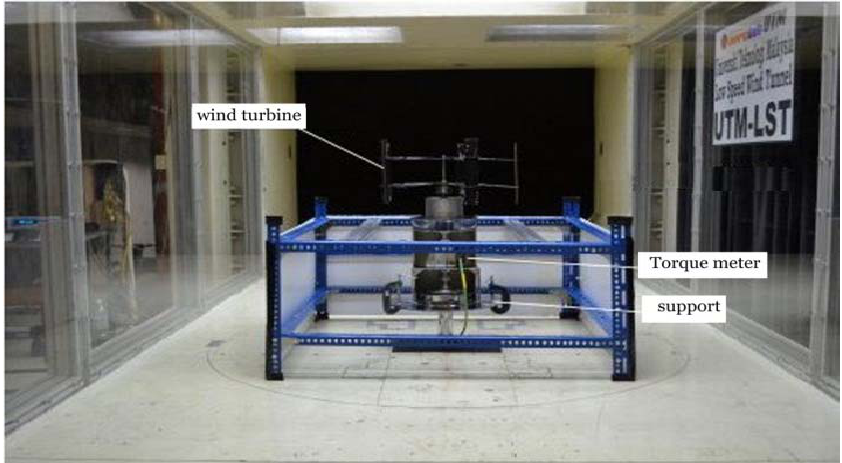
Figure 14. Configuration of the testing unit in wind tunnel.